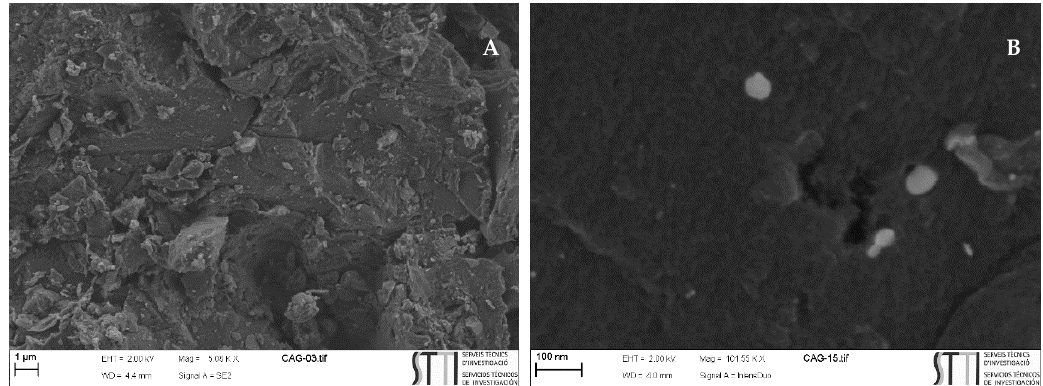
Figure 2. SEM images of GAC at different scales: ( A ) 5080 magnification. ( B ) 100,155 magnification.